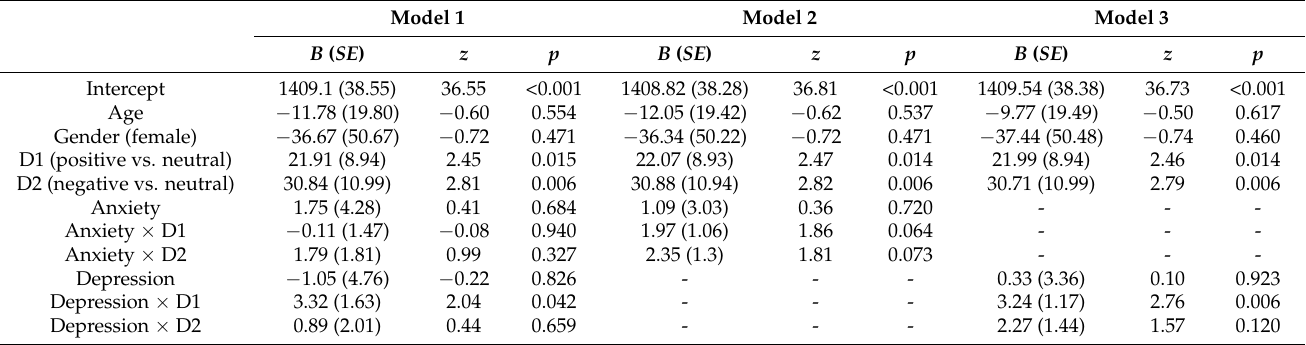
Table 3. Results of MLMs with anxiety and depressive symptoms as predictors of WM updating